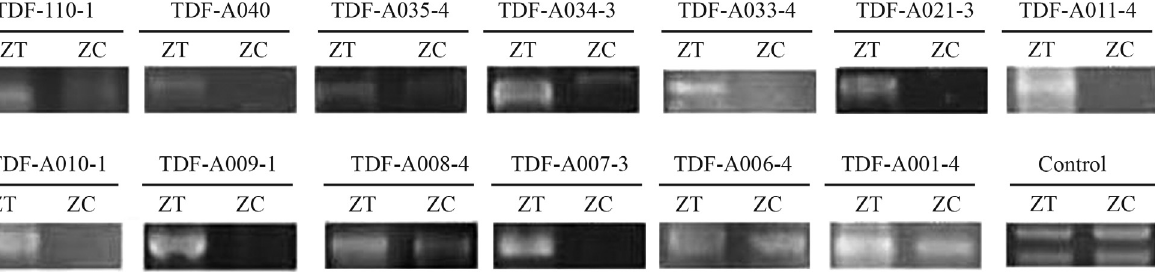
Figure 2 - Confirmation, by semi-quantitative RT-PCR, of a higher level of TDF expression in the flower bud of early-bolting Angelica sinensis (Oliv.) Diels.(ZT: flower bud, ZC: sprout-shoot apical